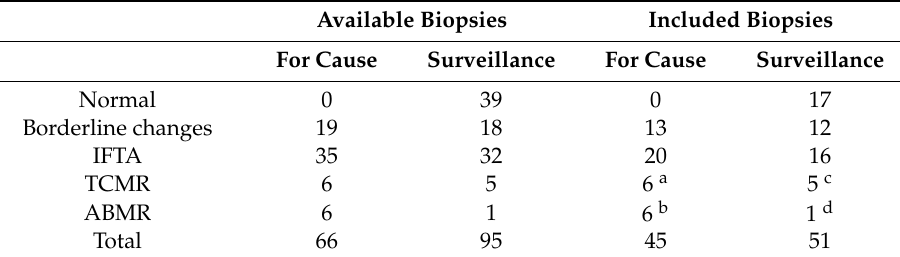
Table 1. Available and included for cause and surveillance biopsies.